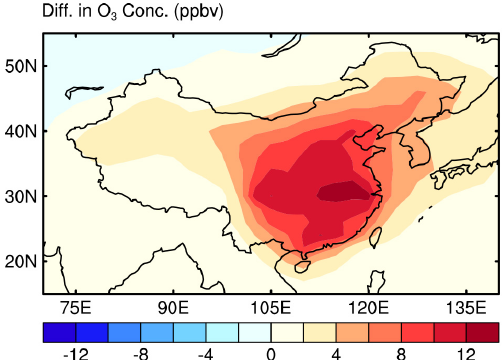
Figure 9. The changes in simulated JJA surface-layer O 3 concen- trations (ppbv) owing to the changes in anthropogenic emissions of O 3 precursors over years 1986–2006, based on simulations of O 3